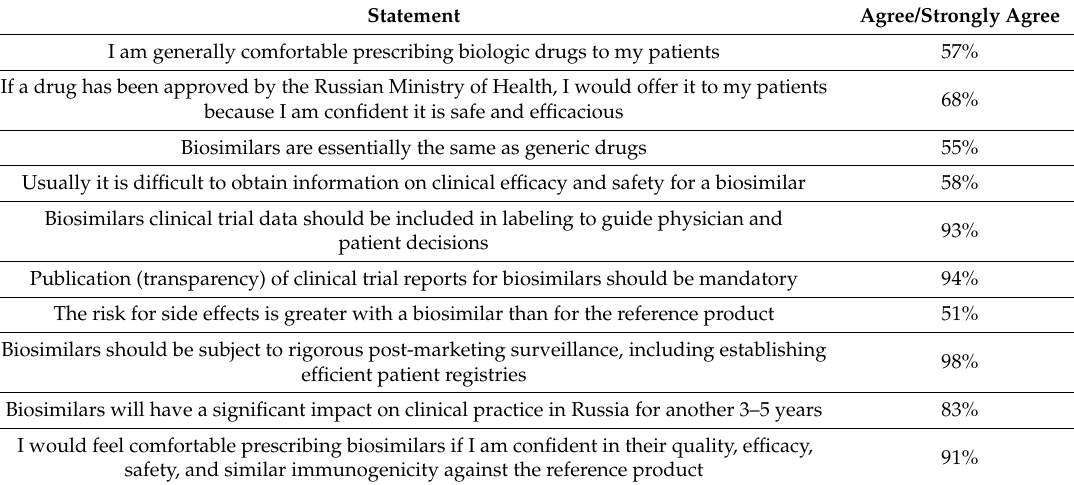
Table 1. Attitudes and perceptions of physicians who responded to the survey about brand-name biologics and biosimilars ( n =